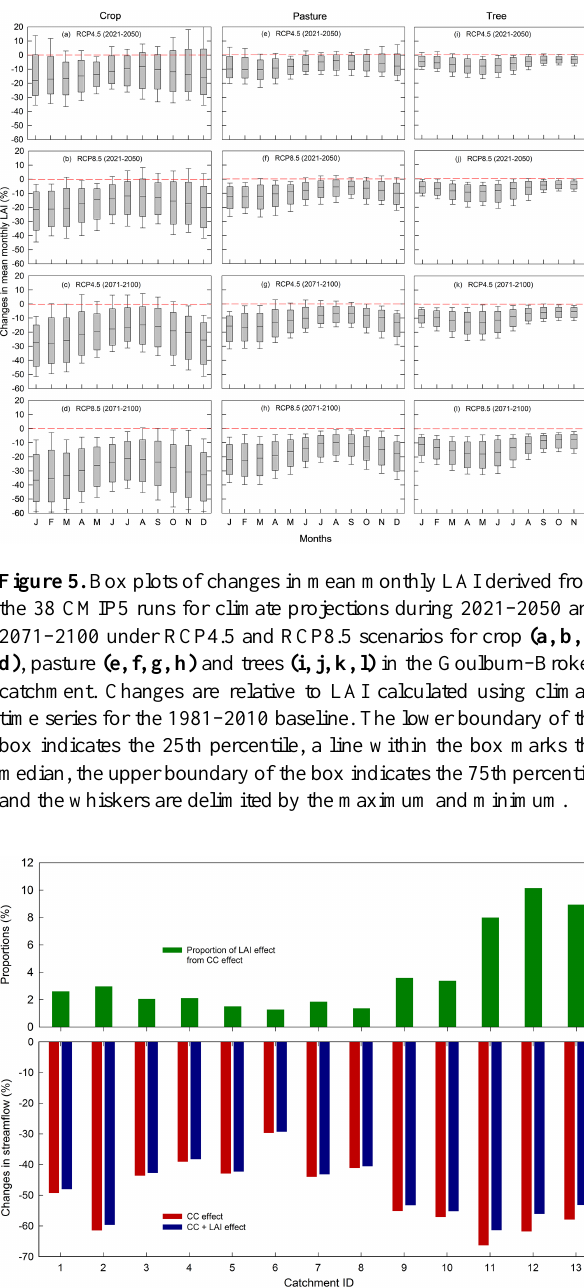
Figure 6. Impacts on catchment mean annual streamflow of the Mil- lennium Drought (1997–2009) relative to the period 1983–1995. CC effect indicates precipitation and temperature effect with un- changed LAI; CC + LAI effect indicates precipitation, temperature and LAI effect. The proportional LAI effect indicates the LAI effect as a percentage of the CC effect.